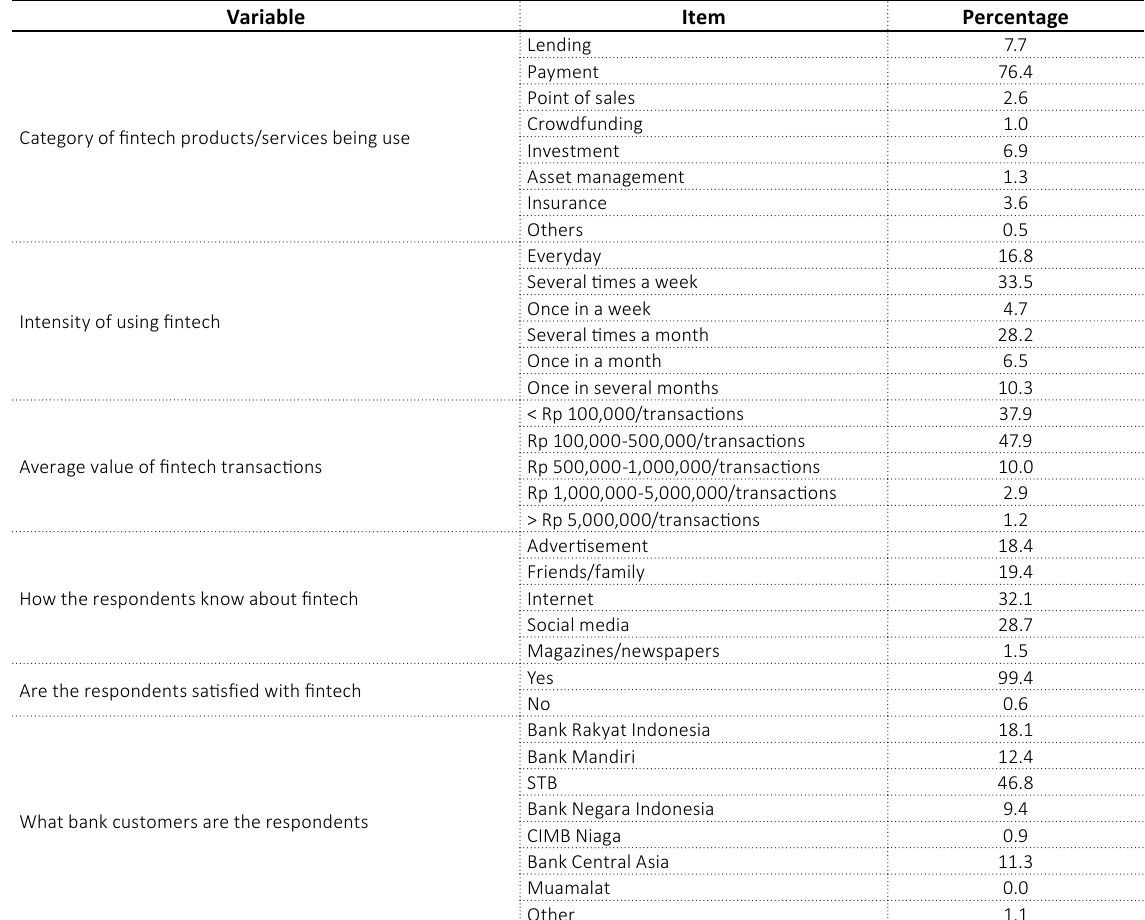
Table 3 (cont.). Respondent demographic profile Variable Item